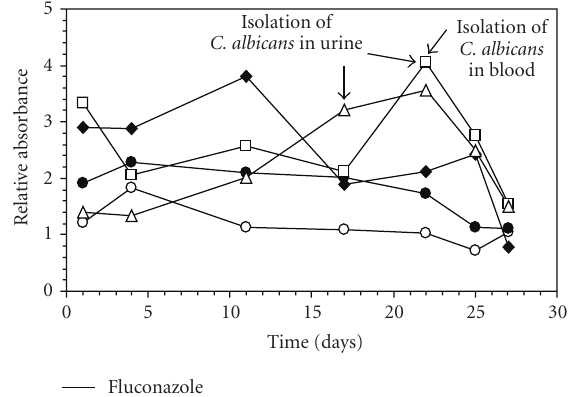
Figure 1: Kinetics of antibody levels against di ff erent C. albicans recombinant proteins in a patient with invasive candidiasis. Ece 1 ( O ), Hyr1 ( (cid:2) ), Als3 ( • ), enolase ( (cid:3) ), and Hwp1 ( Δ ). Arrows point to the days where cultures of urine and blood yielded C. albicans . The bar shows the days the patient was treated with